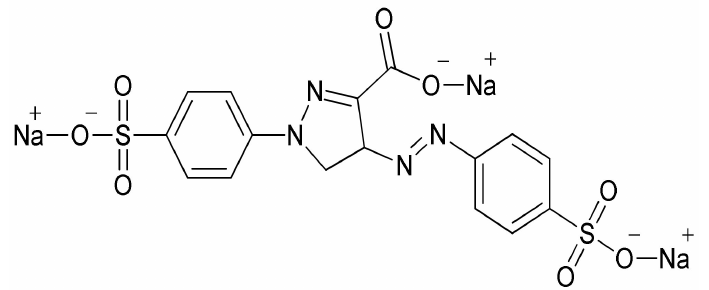
Figure 1. Tartrazine dye